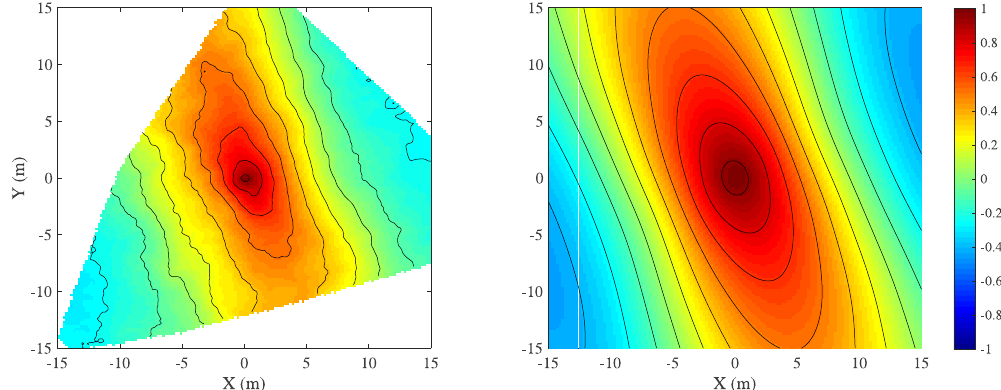
Figure 5. (left panel) Normalized average 3D shape of the measured sea surface elevation field at the time of the rogue waves collected within the record AA1. Only the rogue waves (10 out of 23) occurring close to the center of the observed region were used. (right panel) Normalized ST autocovariance function at the focusing time ( τ = 0) computed using the directional wave spectrum of the sea state in the record AA1. The 3D fields are shown in the geographic reference system.